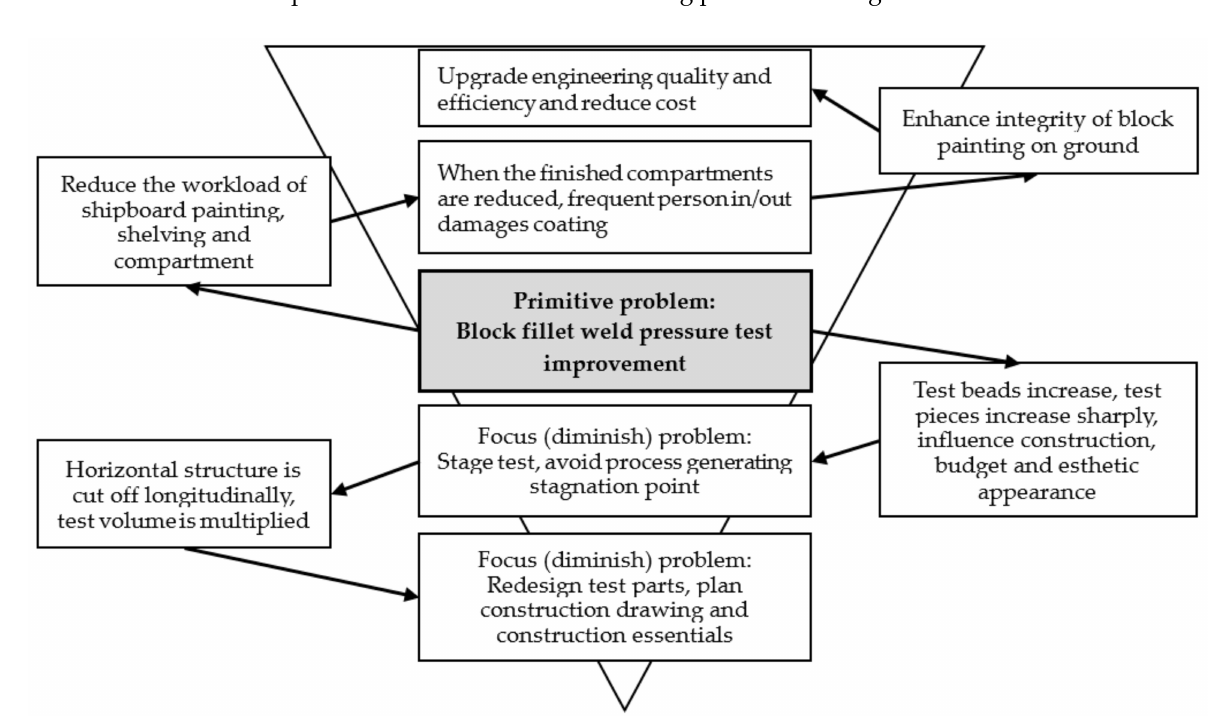
Figure 5. Problem hierarchy analysis diagram.